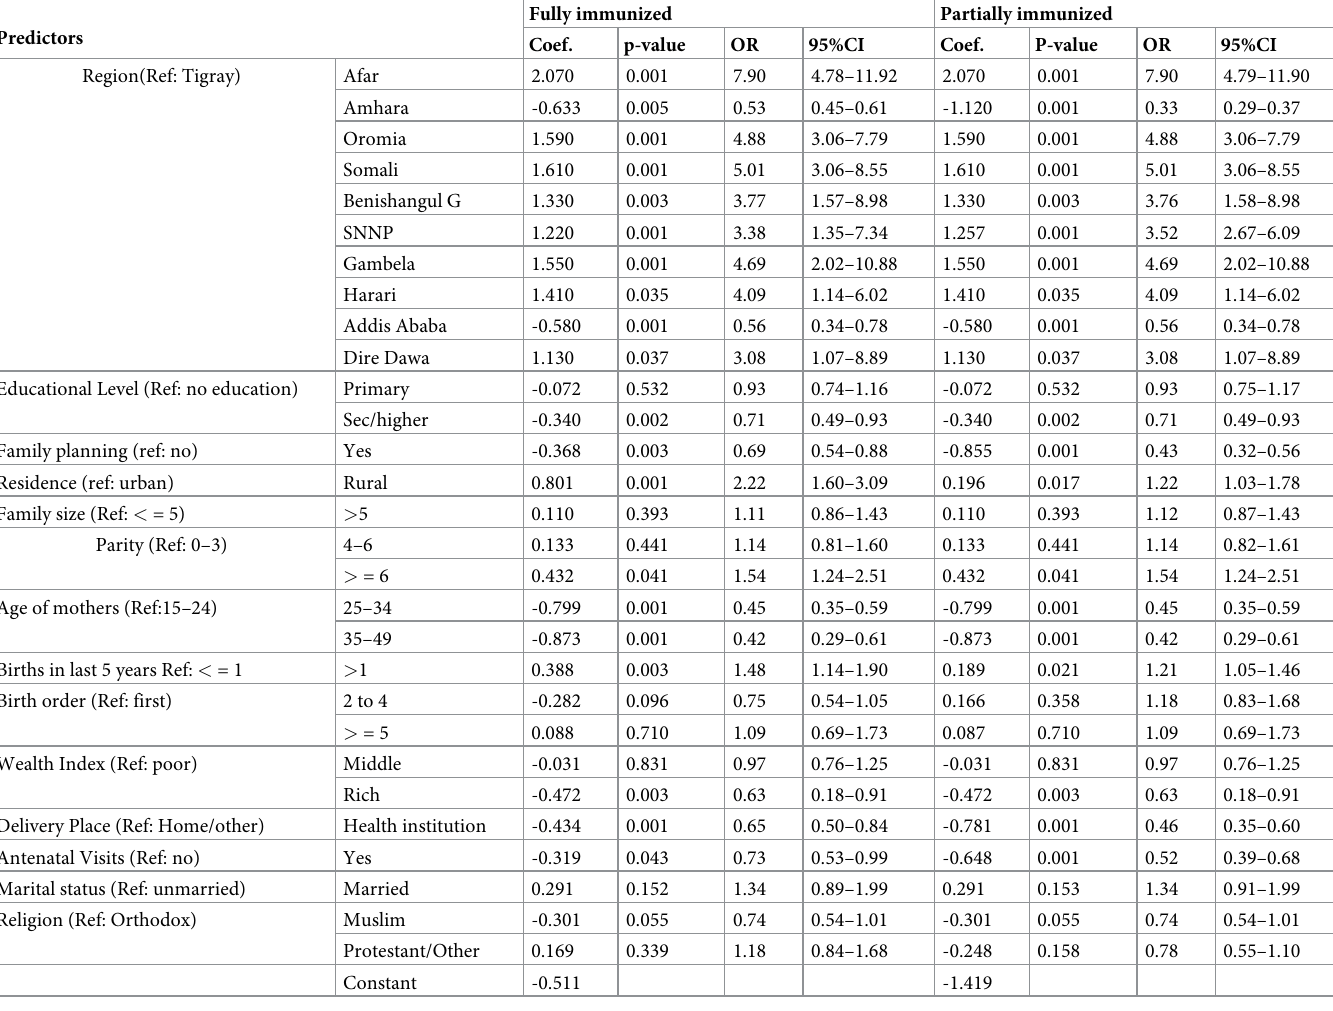
Table 4. Revealed the results of the parameter estimates under PPOM, EMDHS 2019 ( n = 1 , 843 ).